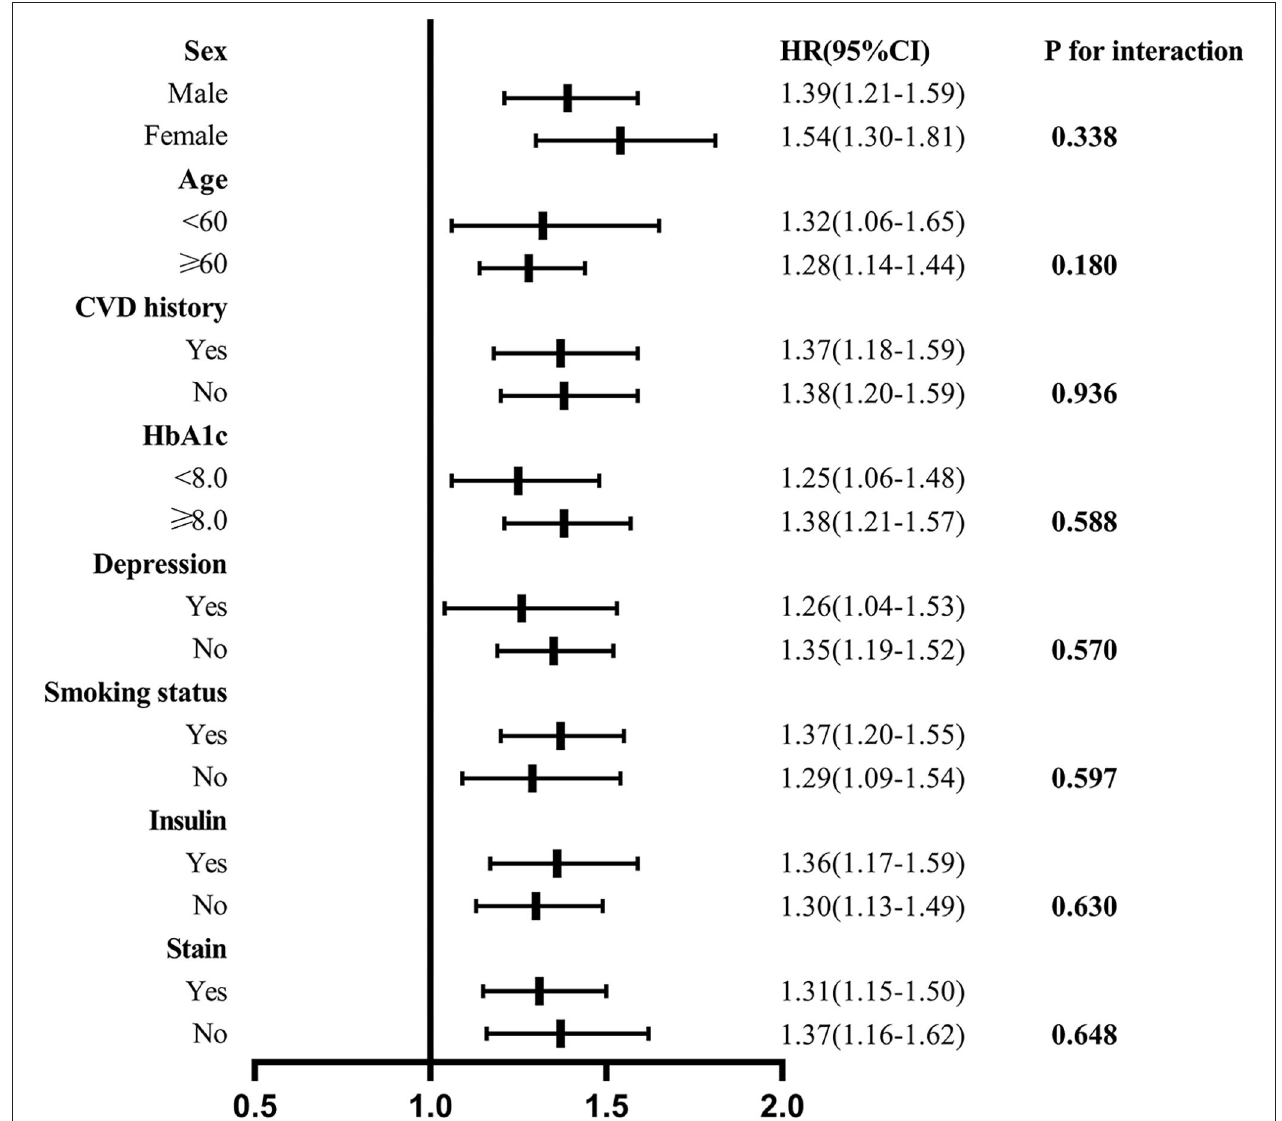
FIGURE 3 | Association between living alone and all-cause mortality in the subgroups. Interaction and stratified analyses were performed to evaluate the association between living arrangements and all-cause mortality in the different